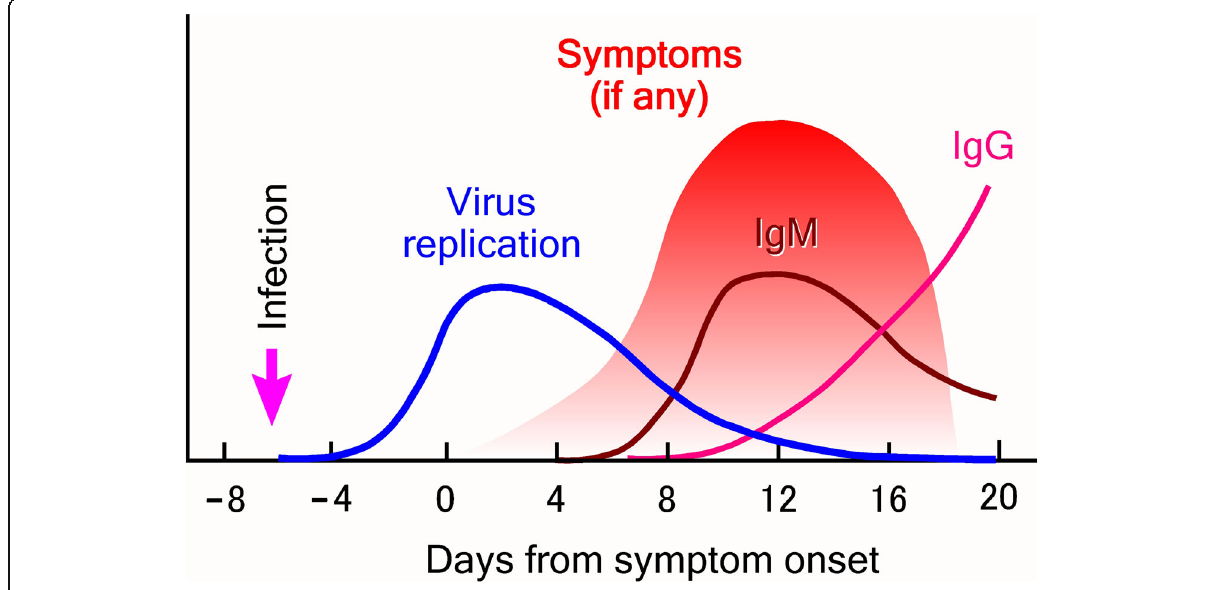
Fig. 3 Diagrammatic representation of the kinetics of SARS-CoV-2 infection. Time course of Ab responses is based on reference